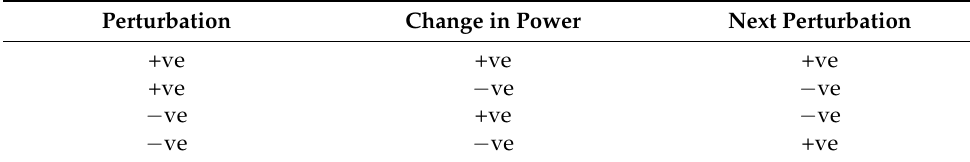
Table 3. Description of the modified Direct-Control Perturbation & Observation technique